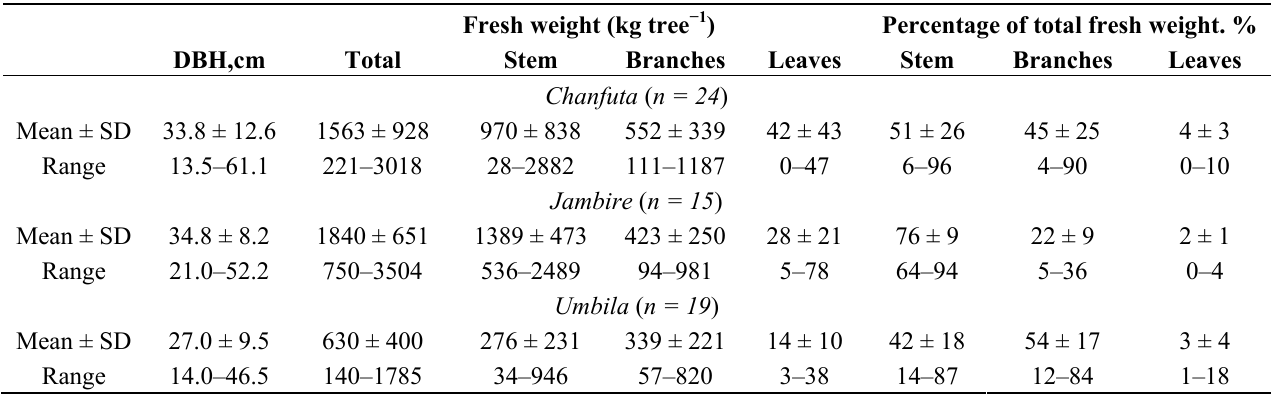
Table 3. Fresh weight of tree components and their proportional